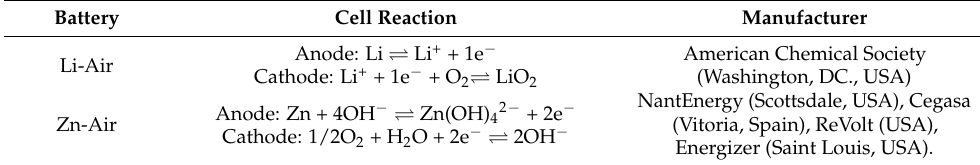
Table 9. Metal–Air Batteries. Characteristics and manufacturers.